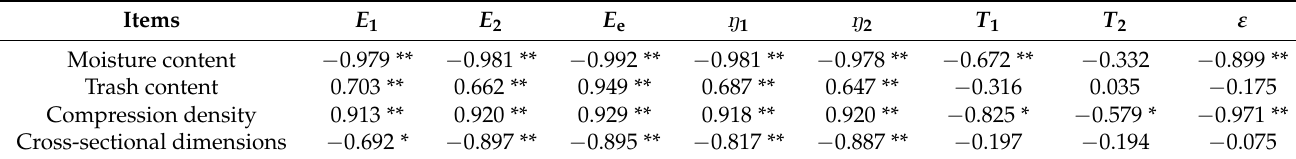
Table 3. Correlation analysis of stress relaxation characteristics